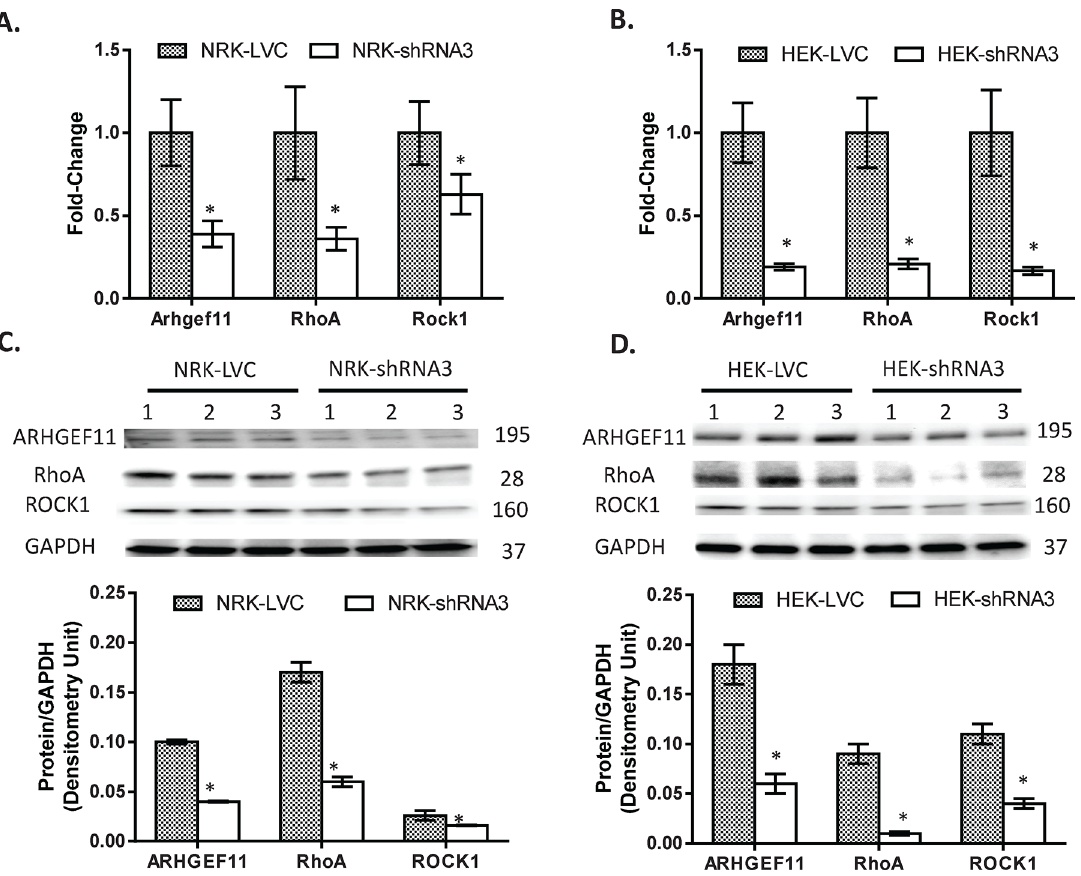
Fig 3. Establishment of stably transduced Arhgef11 knockdown cell lines using shRNA lentiviral methodology. A number of shRNA lentiviral constructs (shRNA1-4) were tested for optimal knockdown of Arhgef11 in both NRK and HEK293T cells (see S2 Fig ). ( A ) Real-time PCR confirmation of shRNA3 Arhgef11 knockdown and subsequent impact on RhoA and ROCK in NRK stably transduced cells compared to scrambled control (LVC). ( B ) Real- time PCR confirmation of shRNA3 Arhgef11 knockdown and impact on RhoA and ROCK in HEK293T stably transduced cells compared to scrambled control (LVC). ( C ) Western analysis and densitometry measurements of ARHGEF11, RhoA, and ROCK between NRK-LVC and NRK-shRNA3.( D ) Western analysis and densitometry measurements of ARHGEF11, RhoA, and ROCK between HEK293T-LVC and HEK293T-shRNA3. n = 4 – 6 independent samples/group, * p < 0.05 versus LVC, Error bar are ± SD.